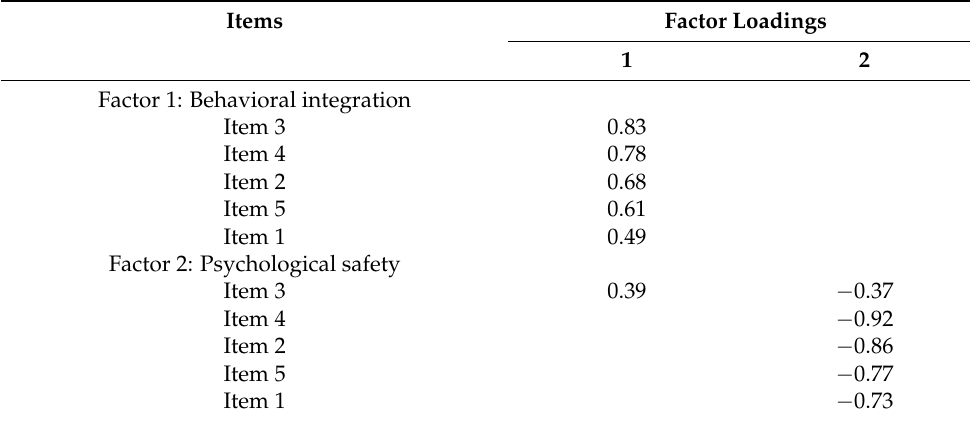
Table 1. Results from a principal component analysis of the two scales measuring Behavioral integration and Psychological safety.